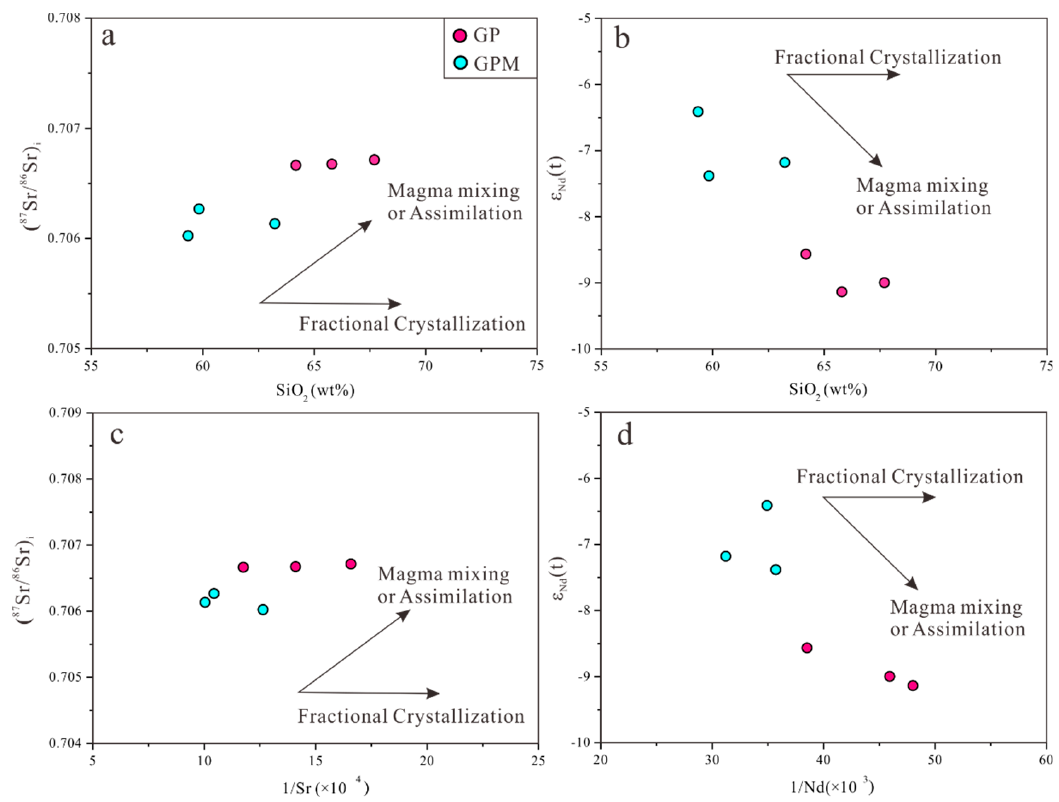
Figure 13. Plot of ( a ) 87 Sr/ 86 Sr versus SiO 2 (wt. %), ( b ) ε Nd (t) versus SiO 2 (wt. %), ( c ) ε Nd (t) versus 1/Sr, and ( d ) ε Nd (t) versus 1/Nd of the Qiaomaishan